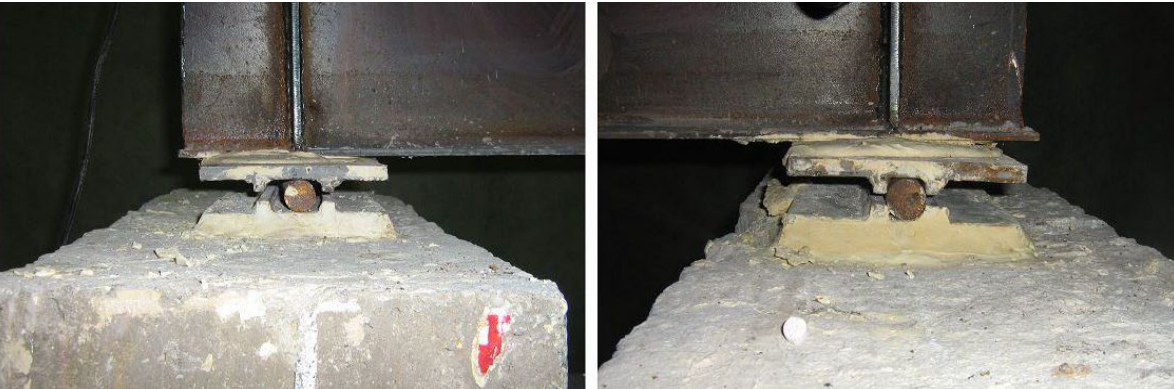
Figure 14. Composite beam support.